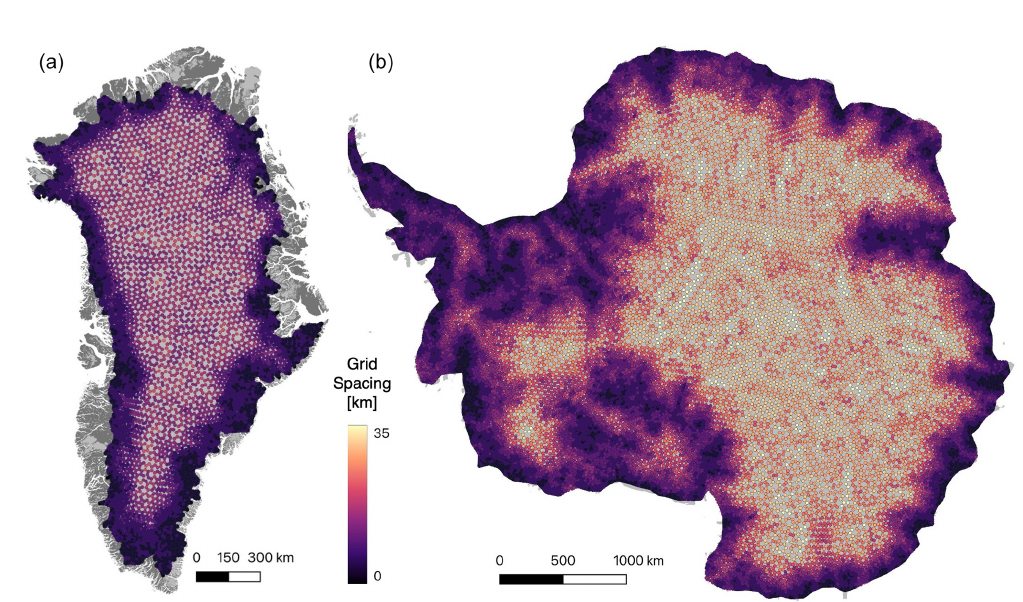
Figure 2. GEMB Greenland (a) and Antarctic (b) model node locations used for this study.